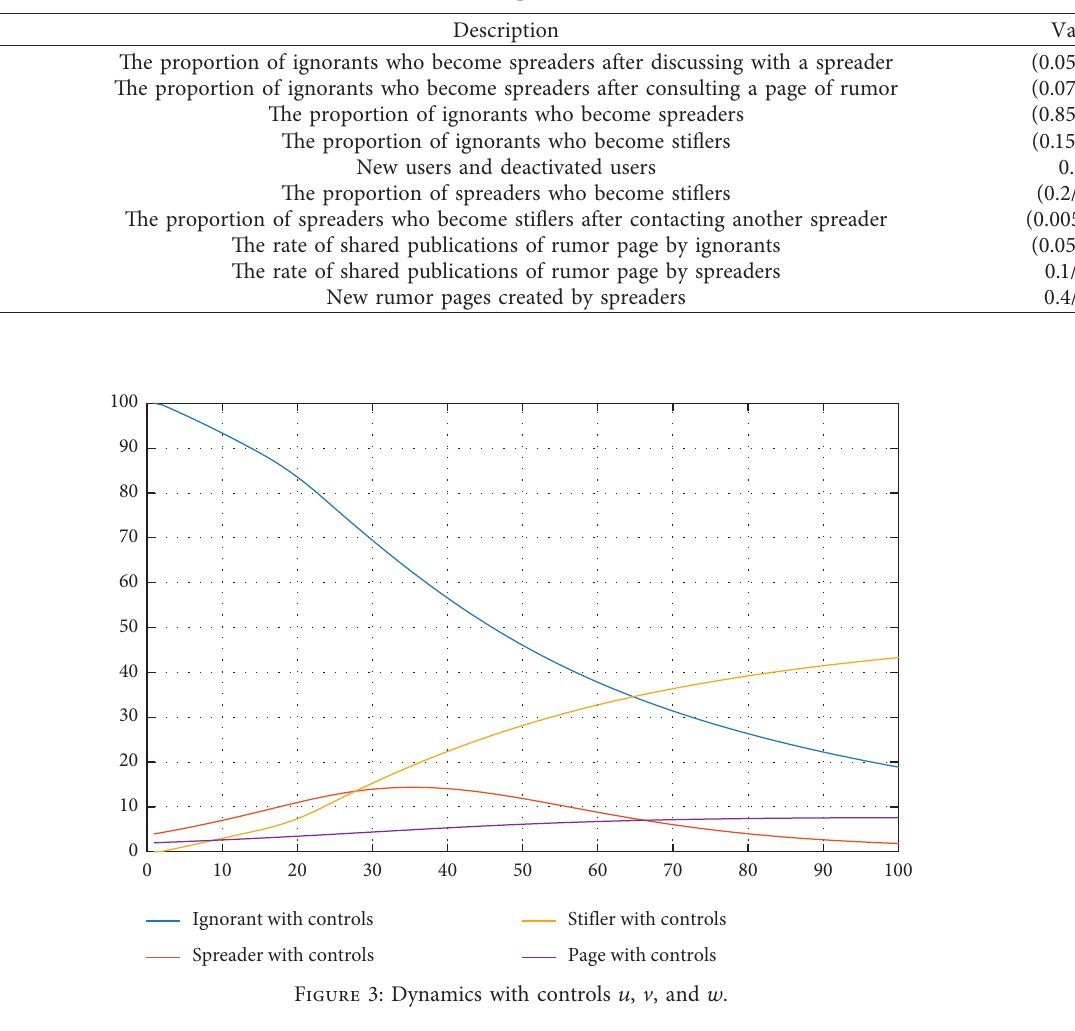
Table 1; with regard to other initial values, they proposed values after a statistical study.